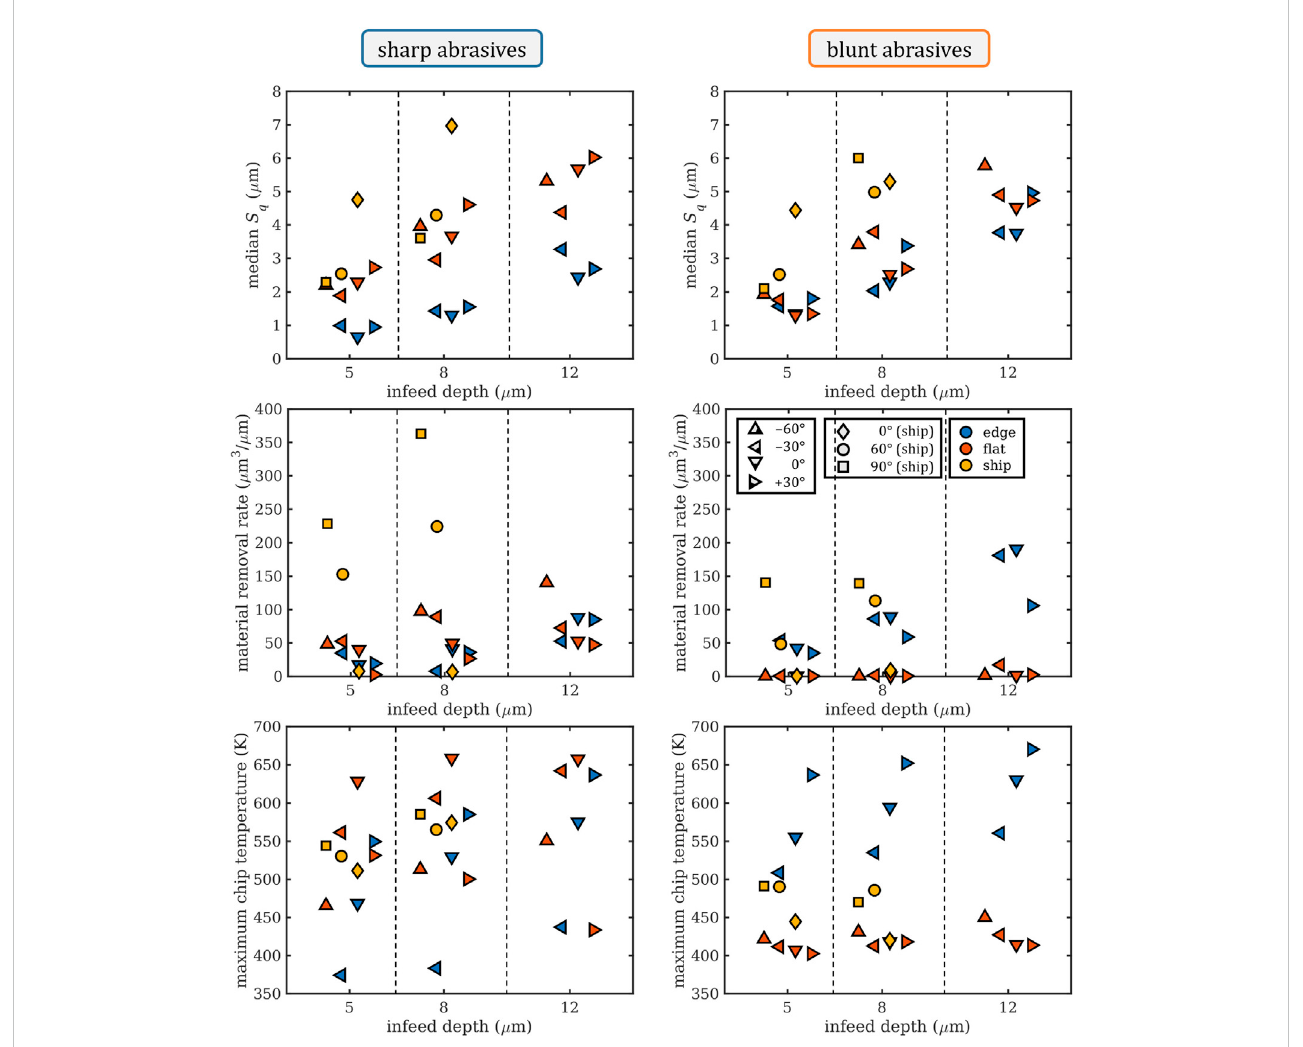
FIGURE 5 Median RMS roughness S q (top), material removal rate (center), and maximum chip temperature (bottom) for sharp (left) and blunt (right) abrasives (3 abrasive grain orientations; edge, fl at, and ship). Symbol colors denote abrasive orientations, and symbol shapes the rake angle. Within each category of infeed depth, the individual rake angles are also staggered from left to right in ascending order. As the grinding velocity was kept at a constant 80 m/s, multiplying the values of the material removal rate by a factor of 80 gives the MRR in units of μ m 3 / μ